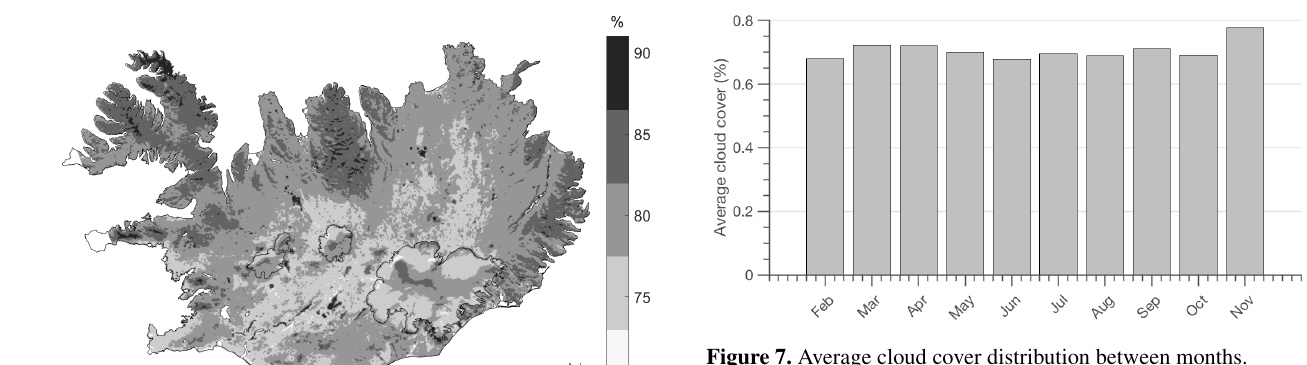
Figure 7. Average cloud cover distribution between